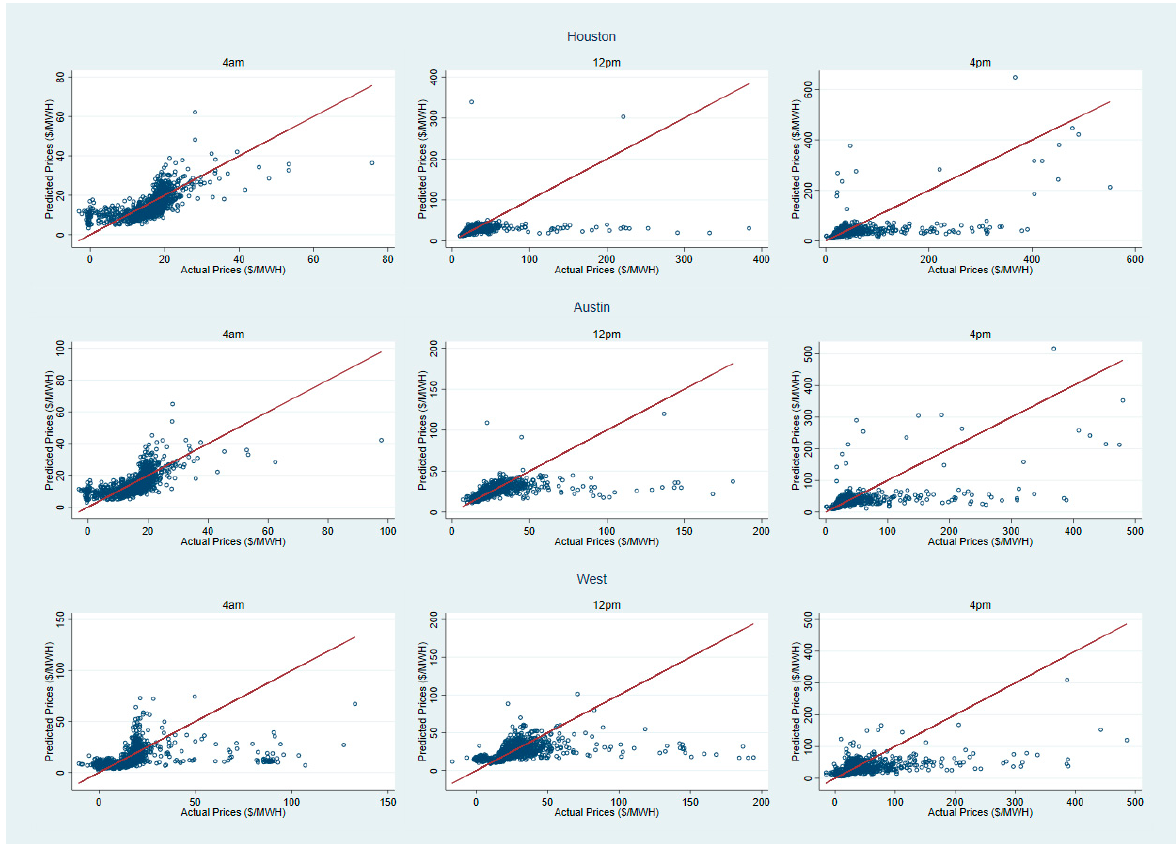
Figure 3. Scatter plots of actual and predicted prices, along with 45-degree lines, in Houston, Austin, and the West for the hours 4:00 a.m., 12:00 p.m., and 4:00 p.m.